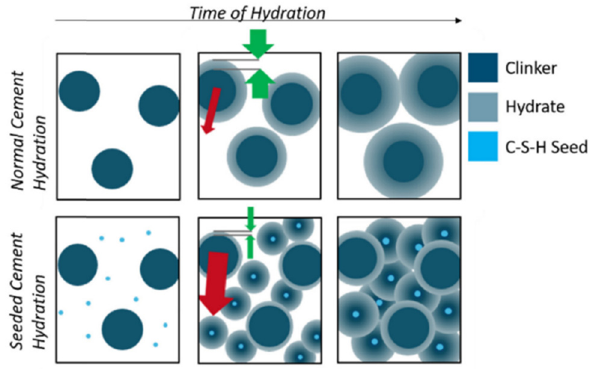
Figure 24: Schematic representation of cement hydration and the in fl uence of nucleation seeding with C – S – H. The red arrows display concentration gradients, while the green arrows highlight the dif - ferent thicknesses of the hydrate formed around the clinker parti - cles, reprinted with permission from ref. [ 105 ] ; Copyright 2018,